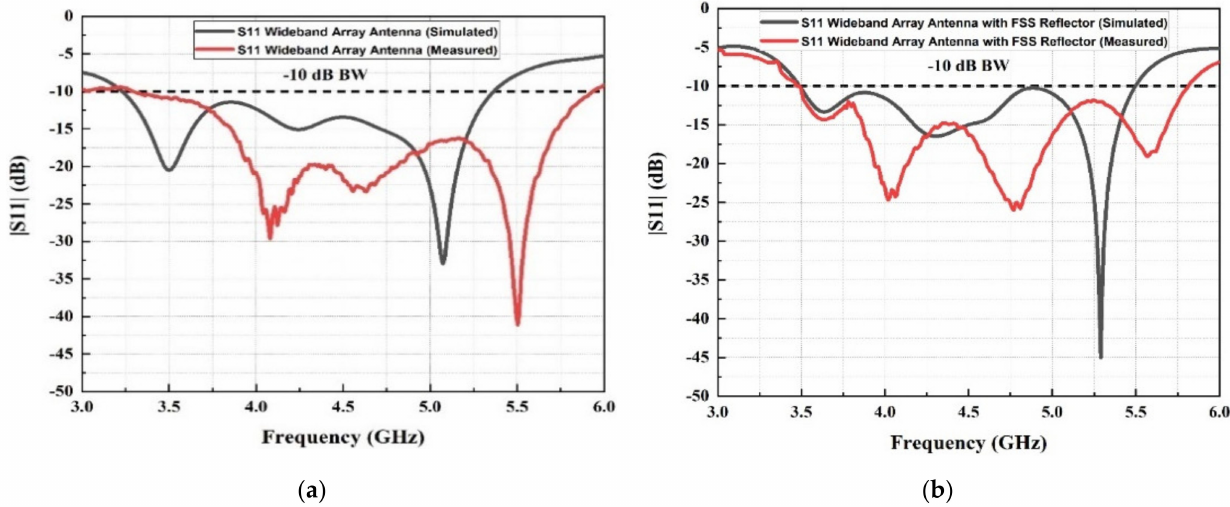
Figure 13. Simulated and measured reflection coefficient (S11) for ( a ) the wideband array antenna without the FSS reflector and ( b ) the wideband array antenna with the FSS